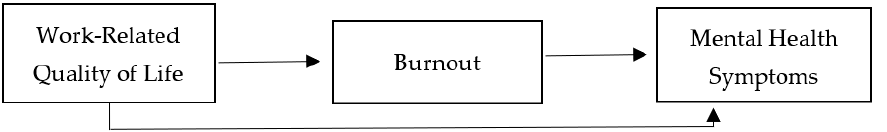
Figure 1. Conceptual model and main variables.